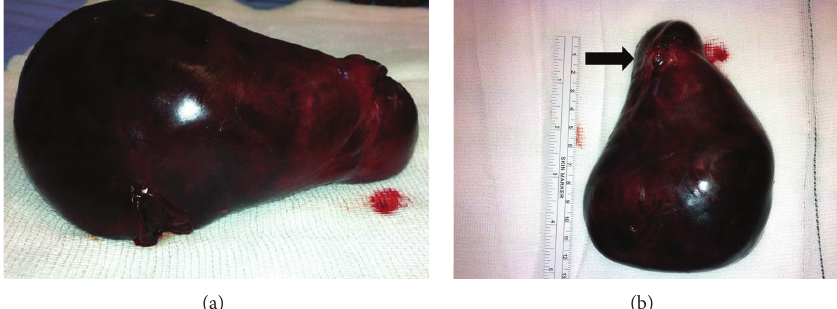
Figure 1: Macroscopic appearance of the myxoid liposarcoma: a dark purple smooth mass measuring 12.5×11×6 cm that weighs 326 grams similar to splenic tissue. The black arrow indicates the stalk by which the liposarcoma was attached to the pelvic wall.